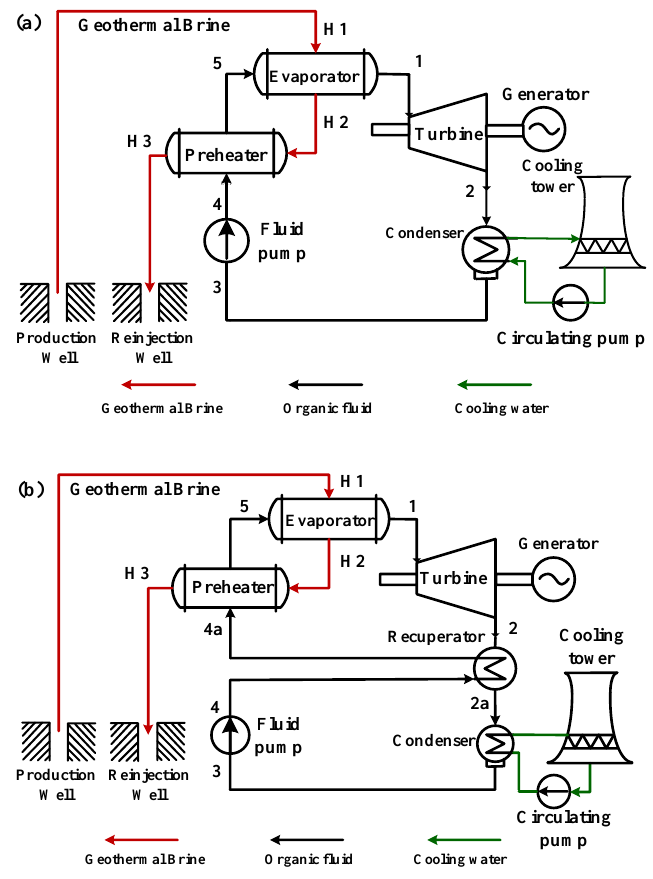
Figure 1. Schematics of ( a ) an ORC and ( b ) RORC with a recuperator.